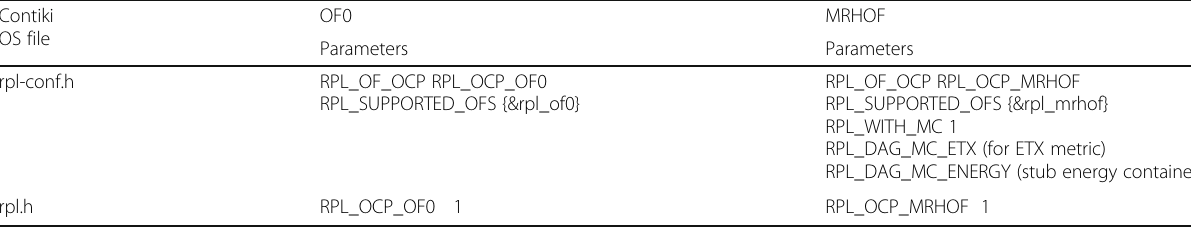
Table 1 ContikiRPL objective function parameters and their associated files Contiki OS file